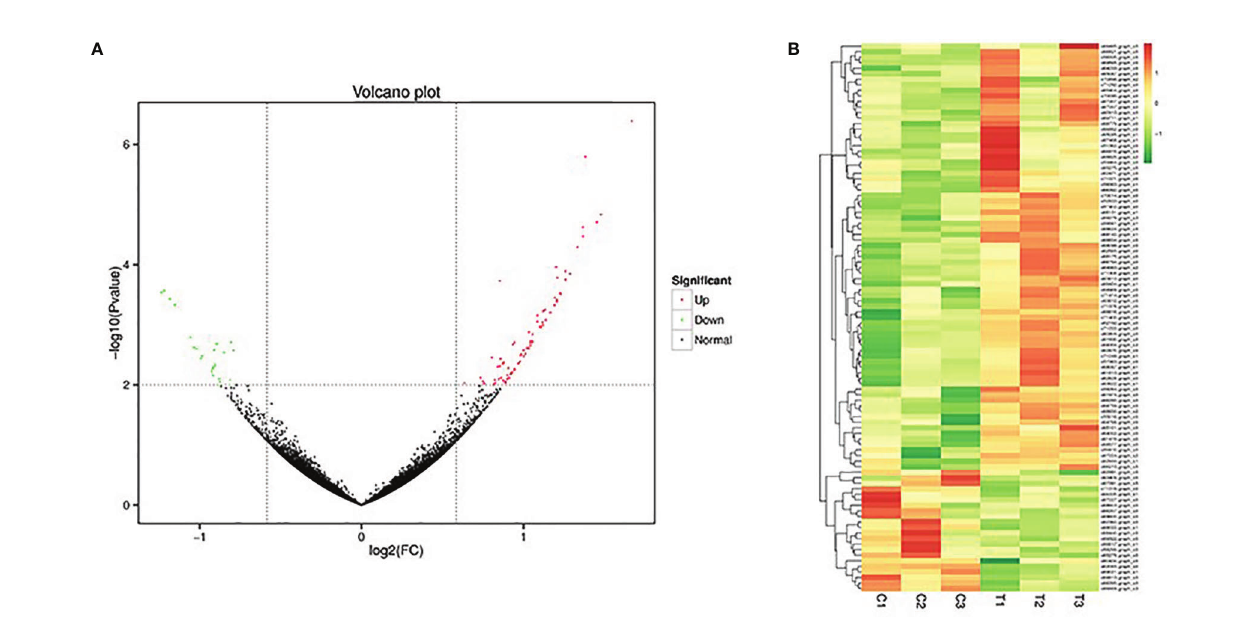
FIGURE 4 | Differential gene expression in the liver of pompano between control group and treatment group. (A) Volcano plot of the differences in gene expression. Each dot represents a gene. The green and red dots in the fi gure represent genes with signi fi cant expression differences, green represents down-regulation of gene expression, red represents up-regulation of gene expression, and black dots represent genes with no signi fi cant expression differences. (B) Heatmap of the hierarchical cluster of DEGs for illustrating the overall pattern of gene expression among different liver